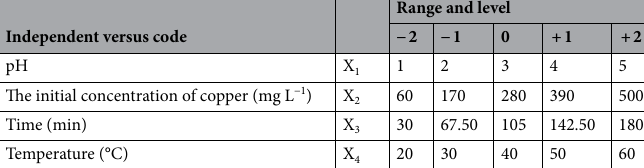
Table 1. Empirical range and levels of independent